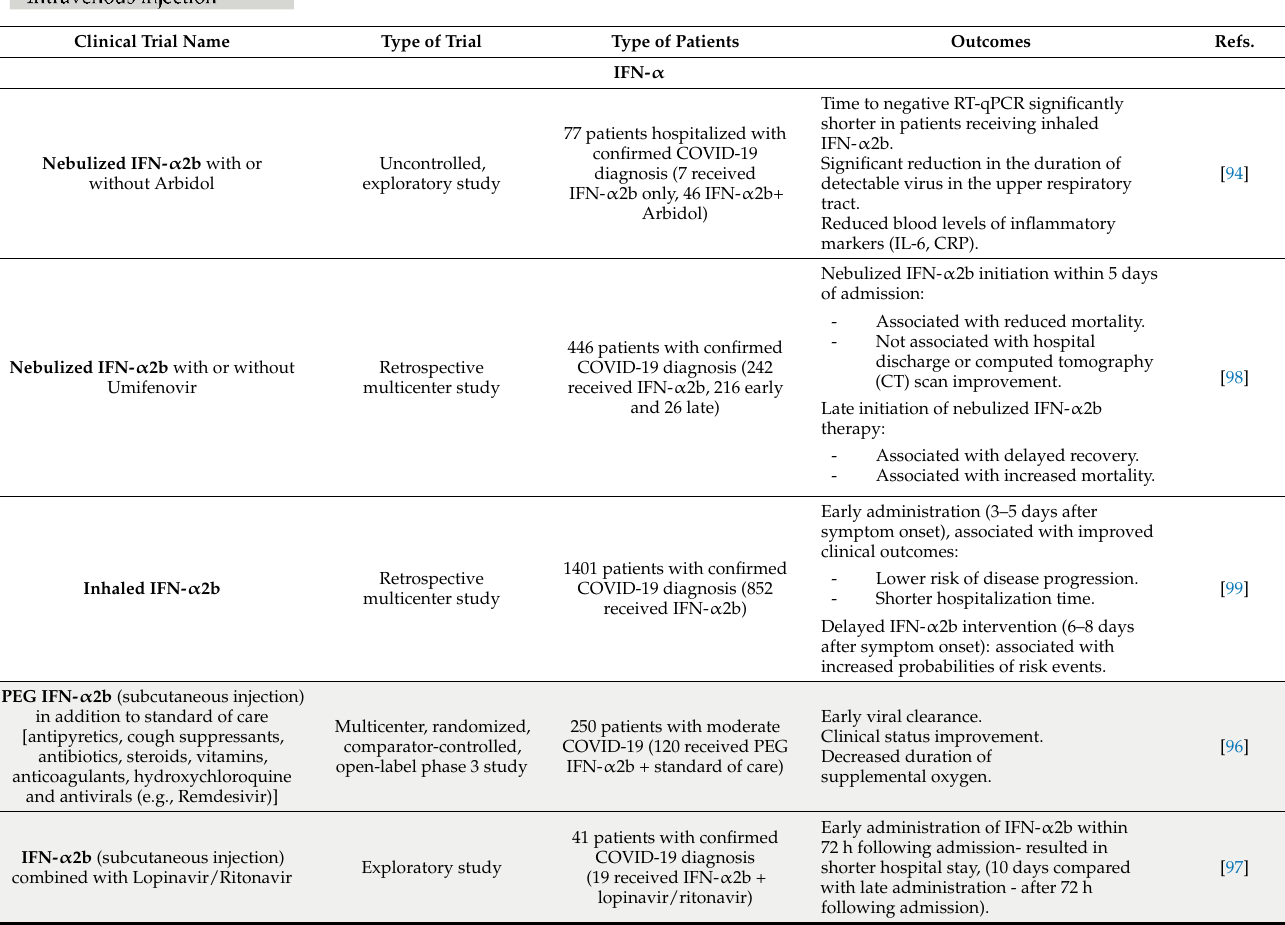
Table 2. Summary of discussed clinical trials with IFN therapies and their outcomes.